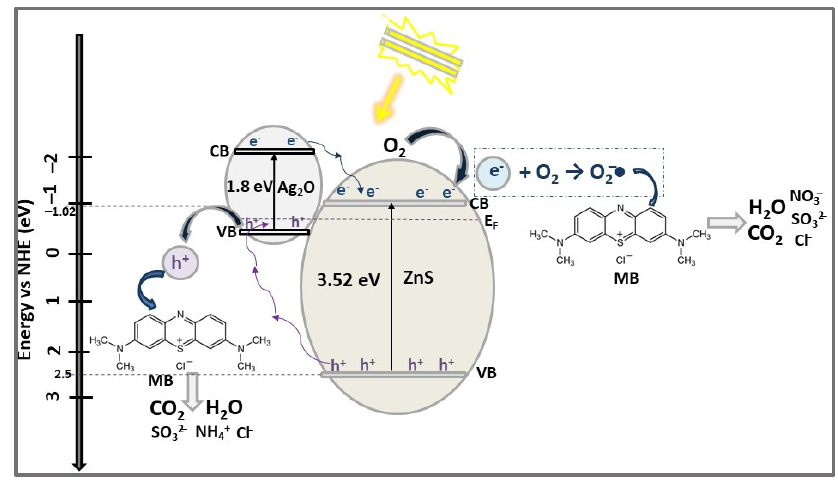
Figure 8. The photocatalytic degradation mechanism of MB dye using ZnS/Ag 2 O heterostructure photocatalyst under Vis light irradiation for 50 min.